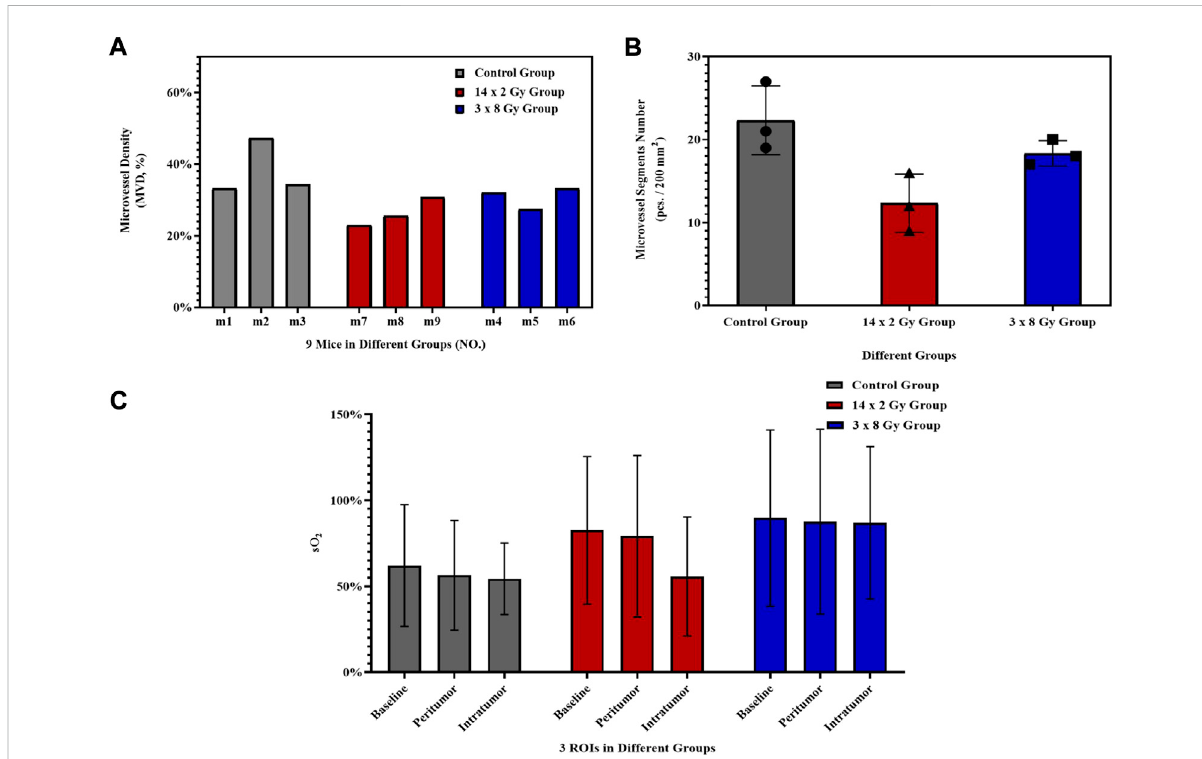
FIGURE 4 Histogram of OA parameters. Histogram of the percentage variation (SEM) of microvessel density (MVD, 100%) (A) and microvessel segments number (B) of4T1breasttumorsafterirradiationatdifferentdoses. (C) Histogramofthepercentagevariation(SEM)ofsO 2 atbaseline,peritumorand intratumor at different doses. The error bar indicated the standard